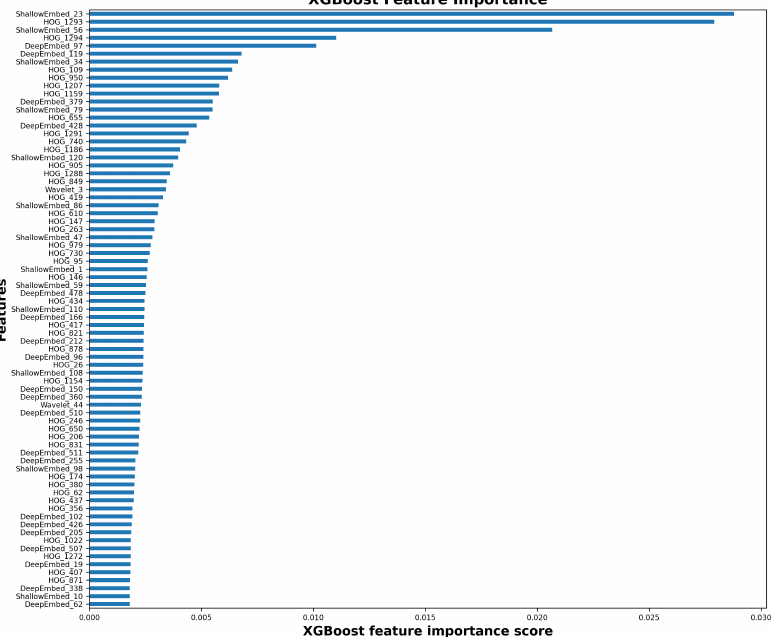
Figure 7. Feature importance ranking for XGBoost—first 75 most important features calculated from all folds used during training